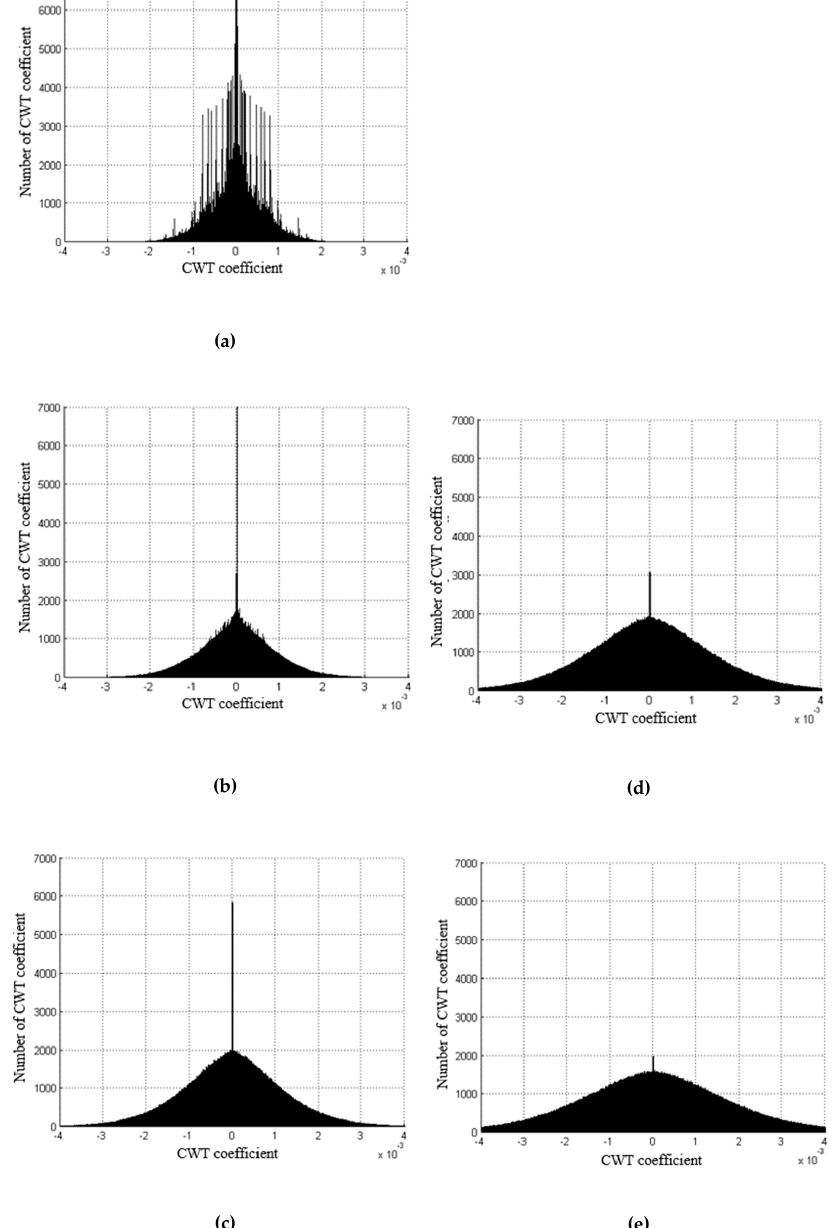
Figure 4. Distribution of continuous wavelet coefficients: ( a ) Scale: 5, ( b ) Scale: 10, ( c ) Scale: 15, ( d ) Scale: 20, ( e ) Scale: 25.